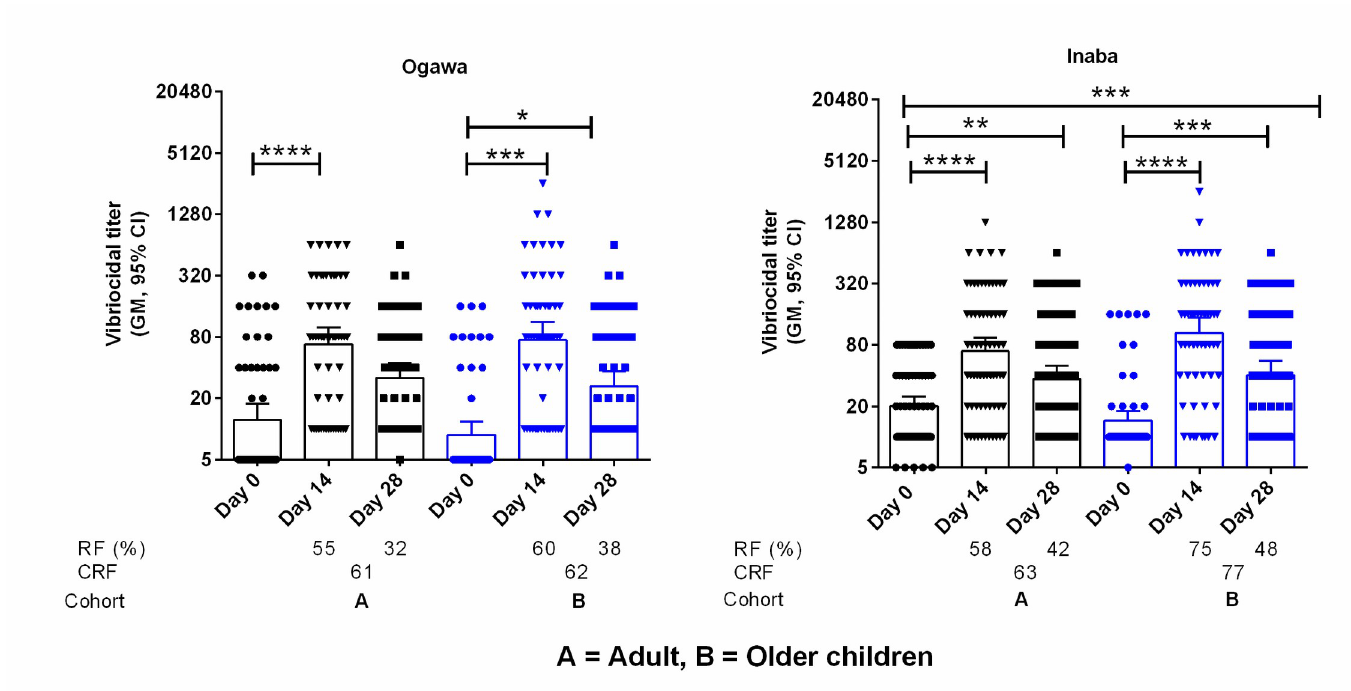
Fig 4. Vibriocidal antibody titer in the DBS eluates of FDMN population to Ogawa and Inaba serotype in adult and older children. Asterisk denote the level of significance ( � , P < 0.05; �� , P < 0.01; ��� , P < 0.001 and ���� , P < 0.0001. Responder frequency (R/F) was calculated as four-fold rise of antibody titer compared to day 0 and cumulative responder frequency (CRF) calculated from either four-fold increase in any day post immunization (day 14 and day 28). https://doi.org/10.1371/journal.pntd.0007989.g004 between DBS eluates and plasma specimens at day 14 among adults (r = 0.5, p < 0.0001) and older children (r = 0.7, p < 0.0001) (Figs 5 and 6) to both V . cholerae O1 serotypes. We also ana- lyzed the agreement of vibriocidal titer between DBS eluates and plasma by the Bland-Altman agreement analysis and observed good agreement of vibriocidal titer at day 14 (Figs 5 and 6). Similar agreement was also observed at day 28.